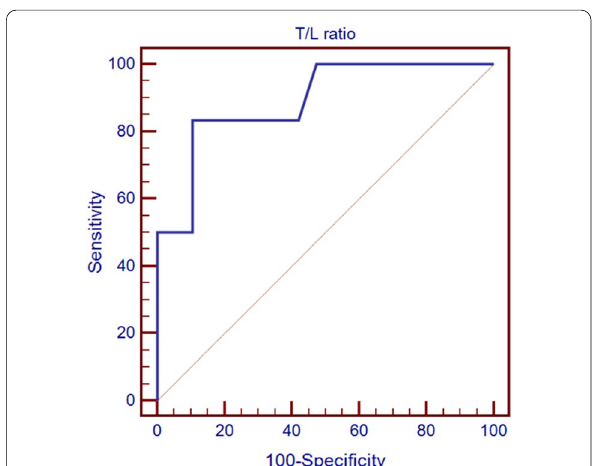
Fig. 6 ROC curve of TLR as a predictor of Her2 molecular subtype